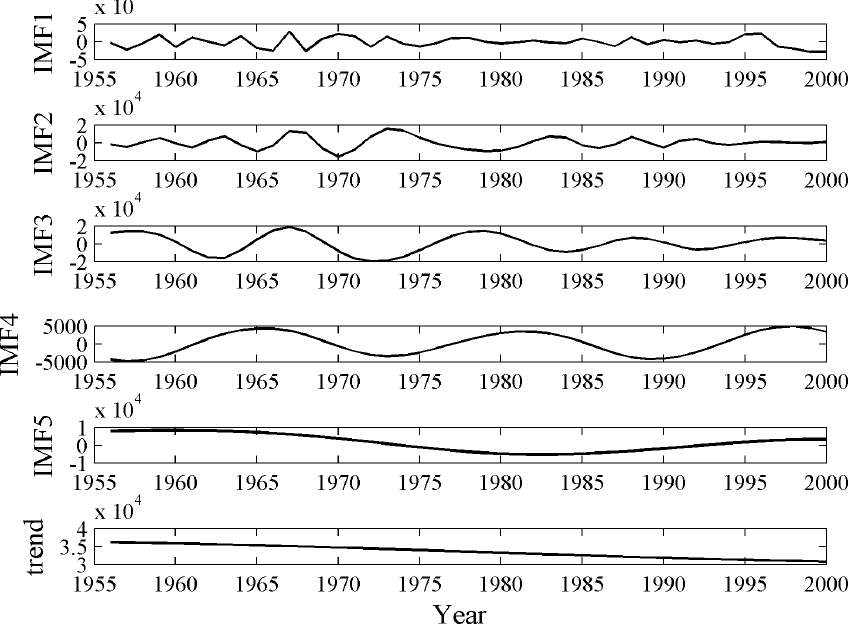
Figure 6. EMD results of runoff series for Fenhe reservoir station.